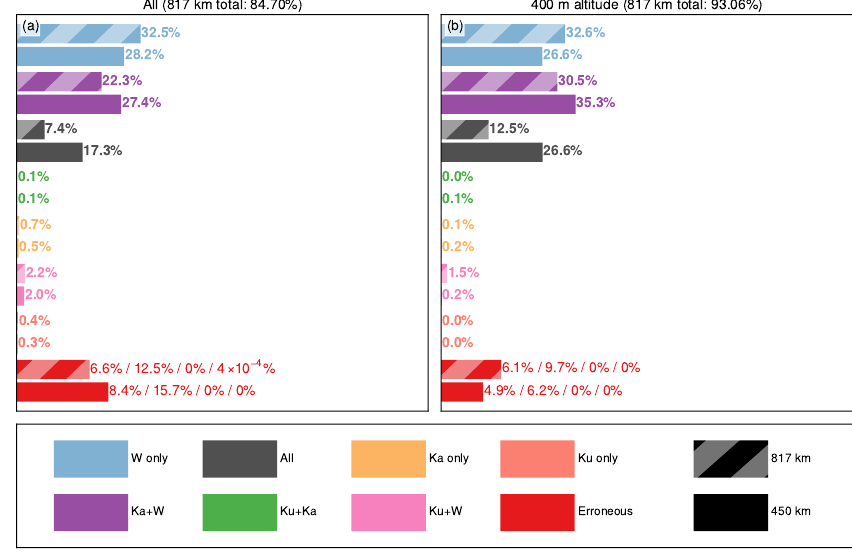
Figure 13. As in Fig. 4, but limited to the region of Fig. 12 (Sect. 5.5; MSC in Fig. 3), and only showing the 400m